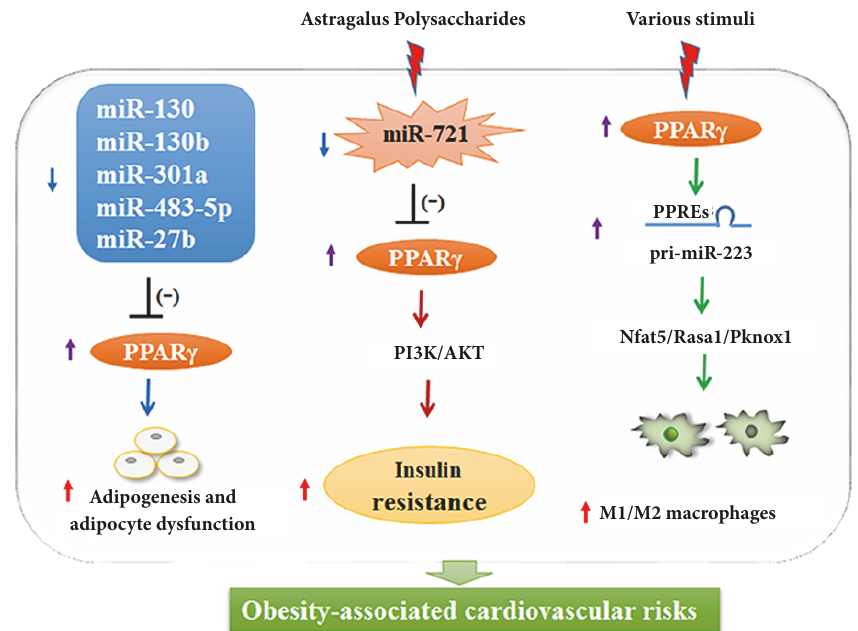
Figure 4: The regulatory function of microRNAs/peroxisome proliferator-activated receptors (PPARs) axis in obesity-associated cardiovas- cularrisks. PI3K:phosphatidylinositol-4,5-bisphosphate3-kinase;Akt:serine/threoninekinase1;Nfat5:nuclearfactorofactivatedT-cells5;Rasa1: RAS p21 protein activator 1; Pknox1: Pbx/knotted 1 homeobox 1; M1/M2 macrophage: proinflammatory M1 macrophage /anti-inflammatory M2